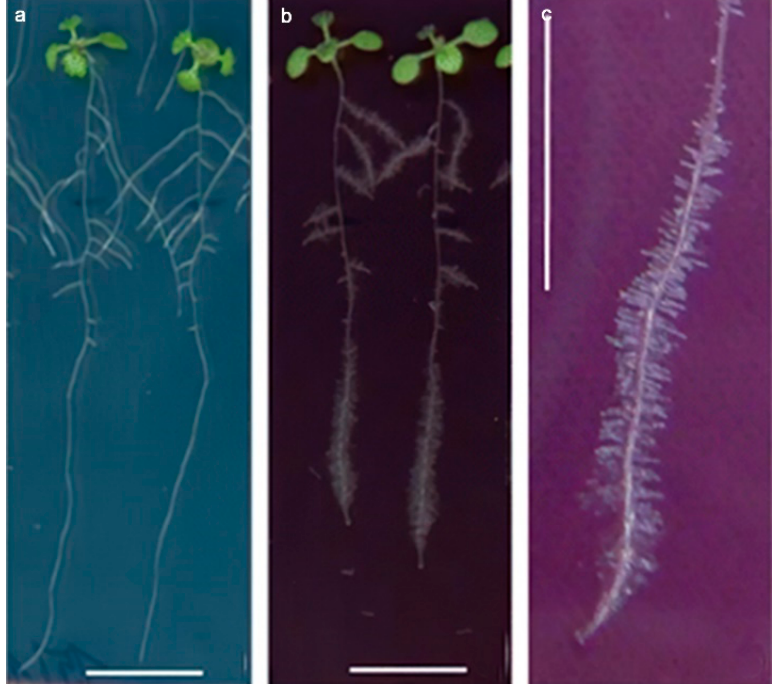
Figure 6. Effect of different concentrations of 10 nm Au NPs on root hair growth in A. thaliana seedlings. ( a ) Control. ( b ) Treated with 100 mg/L of Au NPs. ( c ) Induced root hair growth in plants exposed to 100 mg/L of Au NPs. Reprinted with permission from Ref. [61].